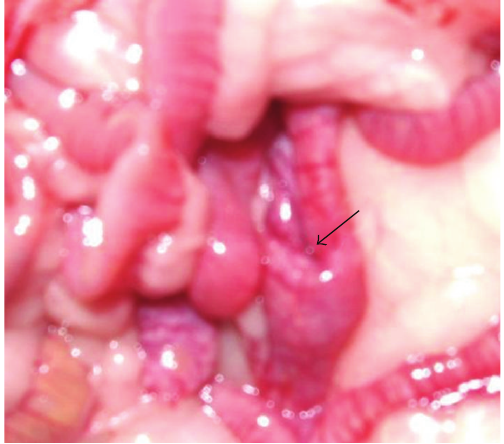
Figure 8: Invagination as a cause of a polyp in colon of a rat in the DSS group.